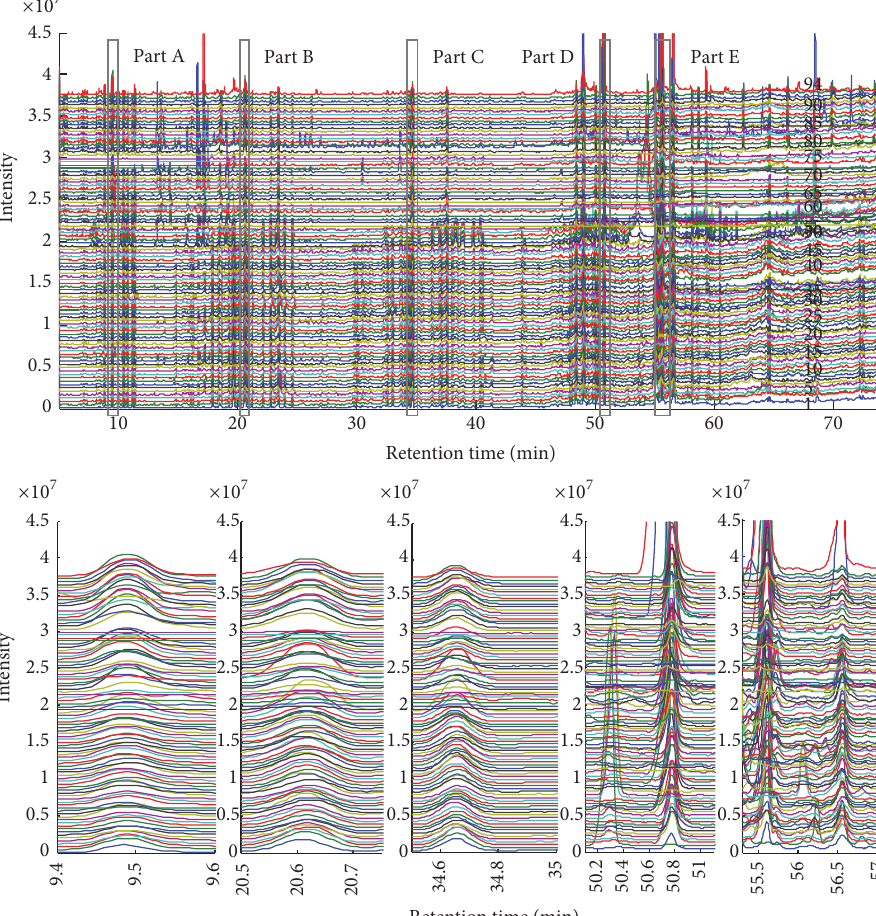
Figure 5: The alignment results of the 94 profiles shown in Figure 4 using the developed method. The five figures from part A to part E correspond to the five elution windows, which are provided to demonstrate the detailed